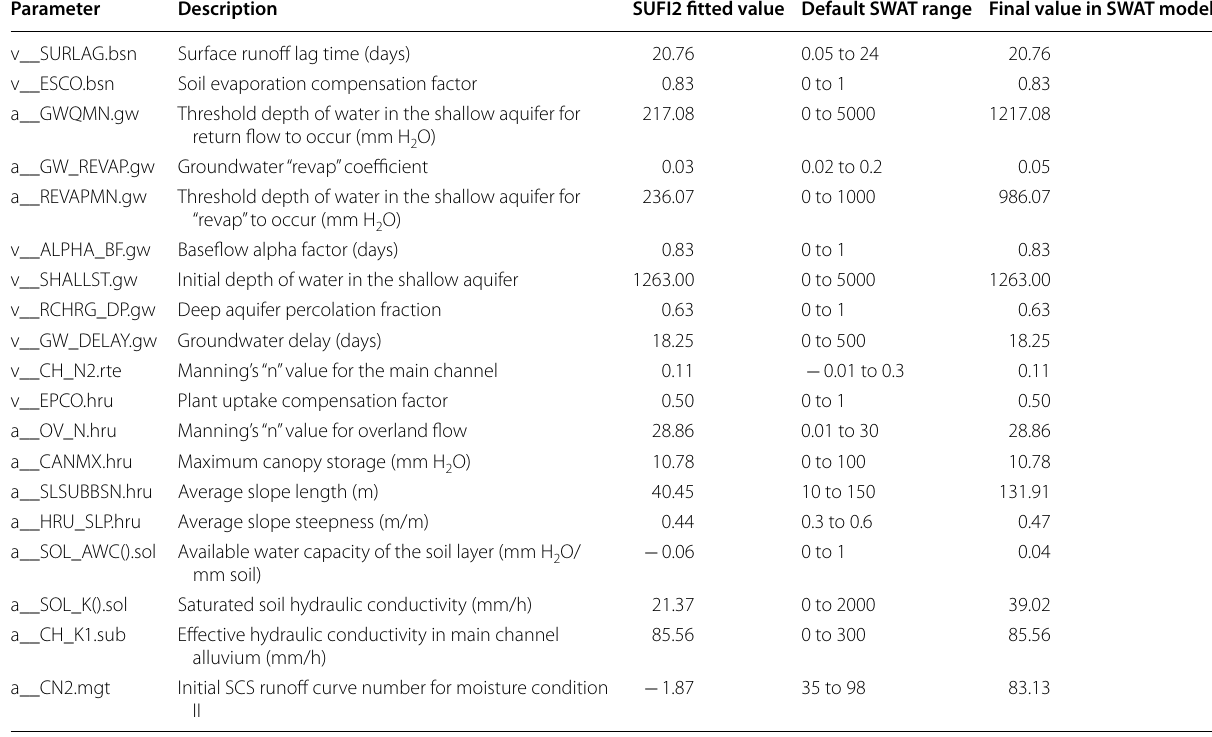
Table 2 Parameters sensitive to streamflow, their default range, fitted value during calibration and final values used in SWAT model for streamflow simulations